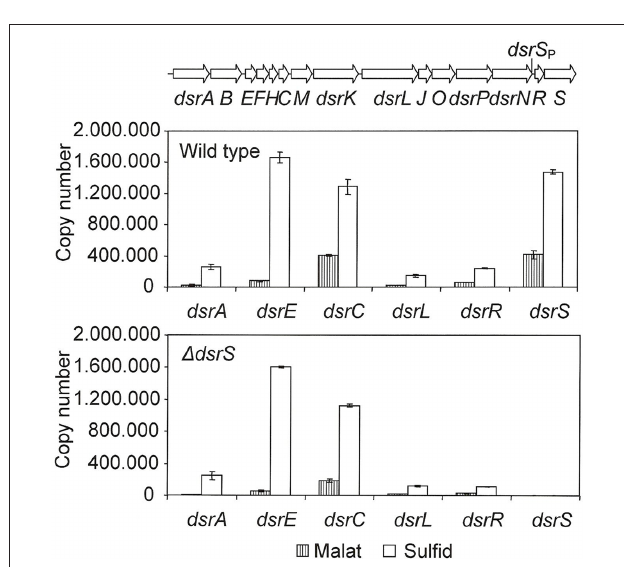
FiGurE 3 | Expression levels of six dsr genes under photoorganoheterotrophic (malate) and photolithoautotropic (sulfide) conditions determined by rT-PCr. The RNAs were isolated from A. vinosum wild type and the ∆ dsrS mutant. Quantified external RNA fragments containing the target sequence served as standards. The location of a potential secondary promoter for dsrS as determined by BPROM and Neural Network Promoter Prediction